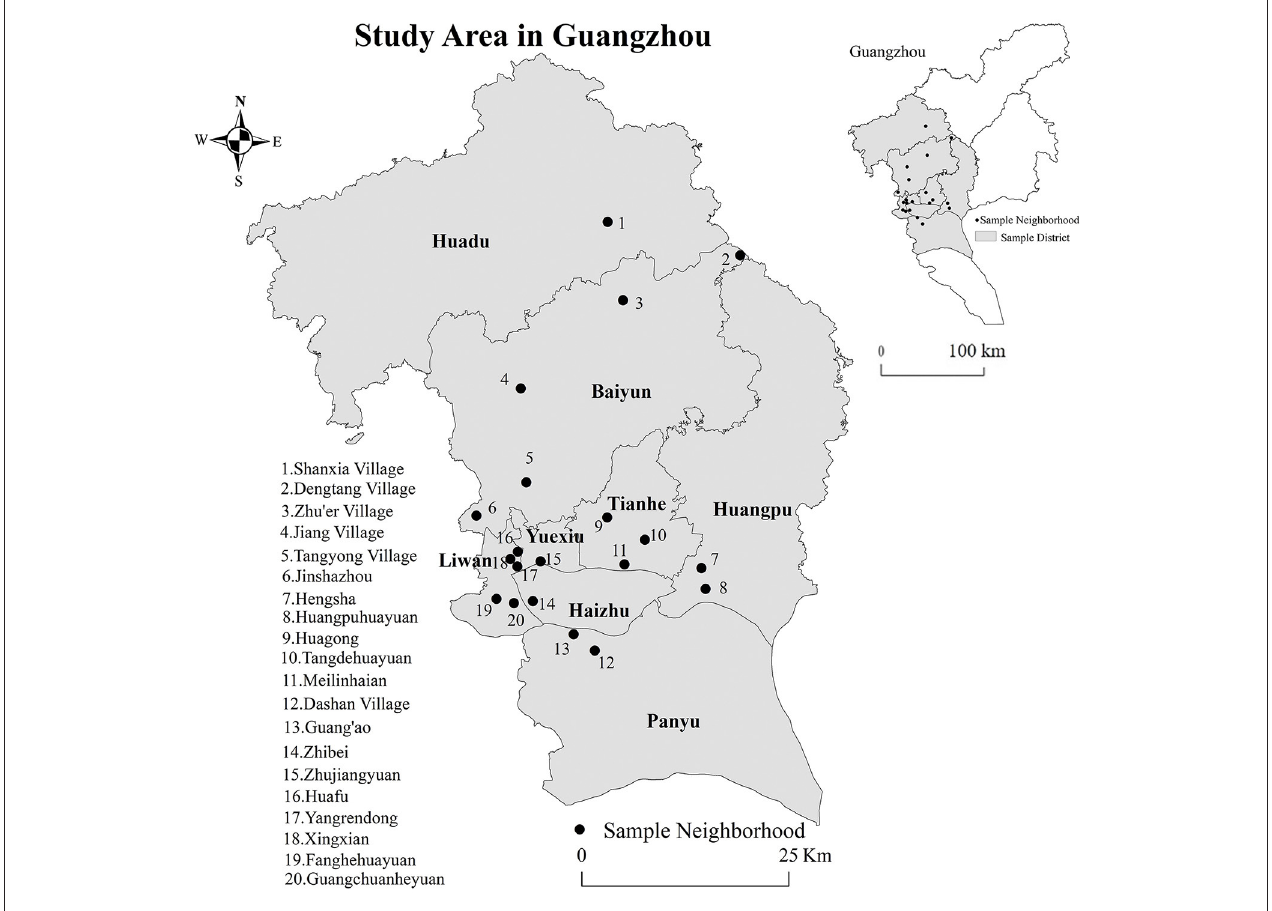
FIGURE 2 | Location of surveyed communities.